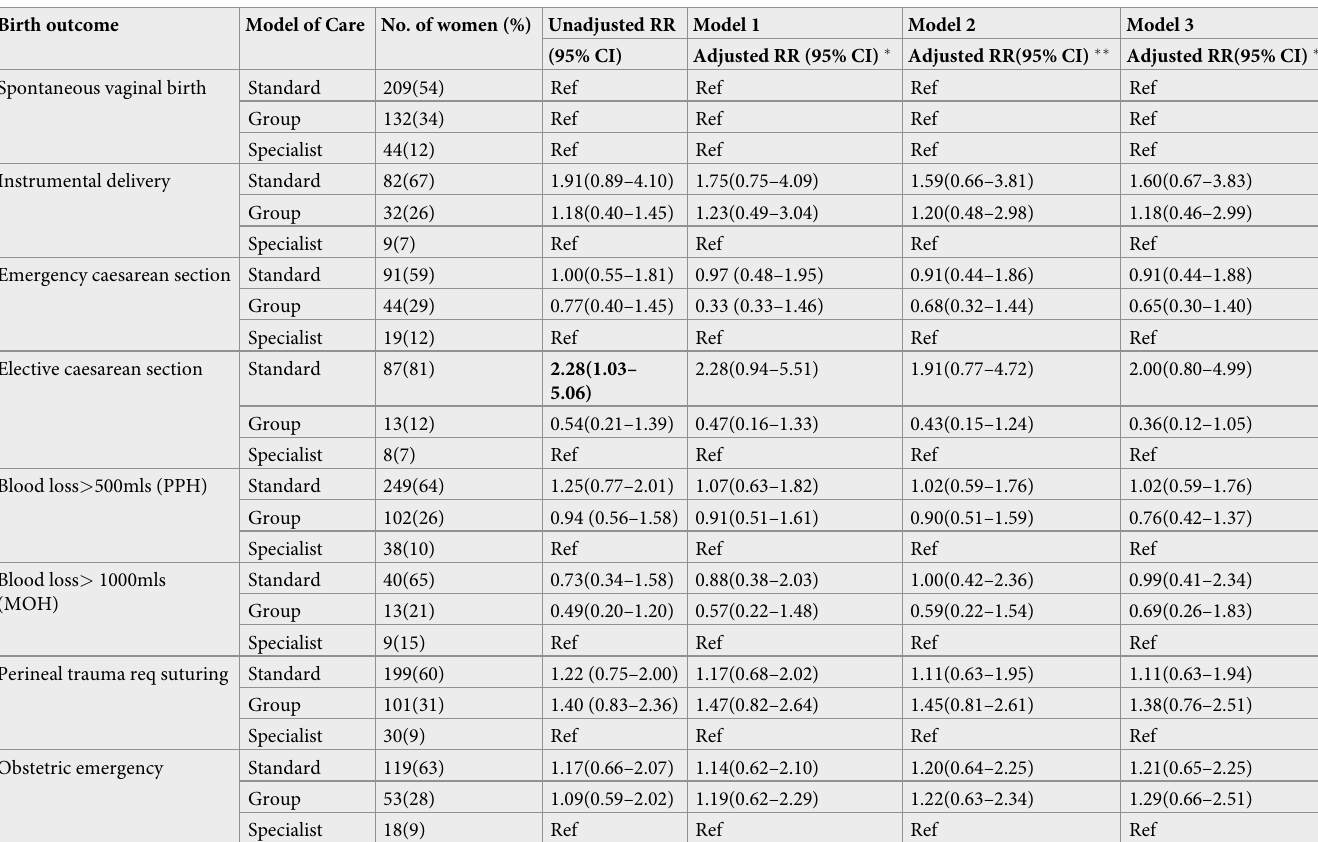
� Model 1: Adjusted for demographics ethnicity, age, parity, IMD score, any social risk factor and medical risk factors at booking and onset of labour. �� Model 2: Model 1 + Adjustment for place of antenatal care (community or hospital). ��� Model 3: Model 2 + Adjustment for service provider attended (A or